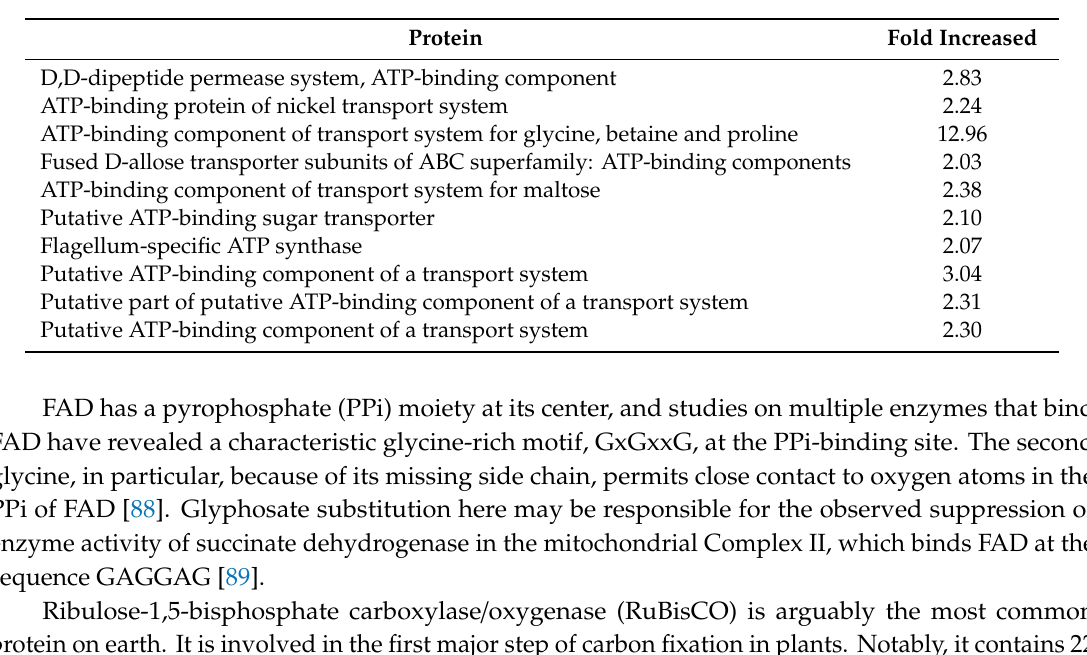
Table 1. ATP-binding proteins upregulated by E coli in response to glyphosate exposure. Reproduced from Lu et al., 2013